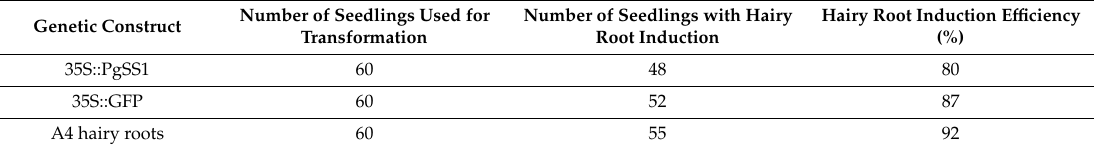
Figure 2. Subsequent stages of obtaining transgenic S. obtusifolia in vitro hairy root cultures. ( A )- S. Table 1. E ffi ciency of hairy root formation on Senna obtusifolia seedlings. obtusifolia seed, ( B )- S. obtusifolia 14 day old seedling used for genetic transformation, ( C , E )-SOPSS hairy roots formation on S. obtusifolia seedlings after Agrobacterium transformation, ( F )- SOPSS hairy roots after 7 days on Murashige and Skoog (MS) selection medium, ( G )- SOPSS hairy roots after 14